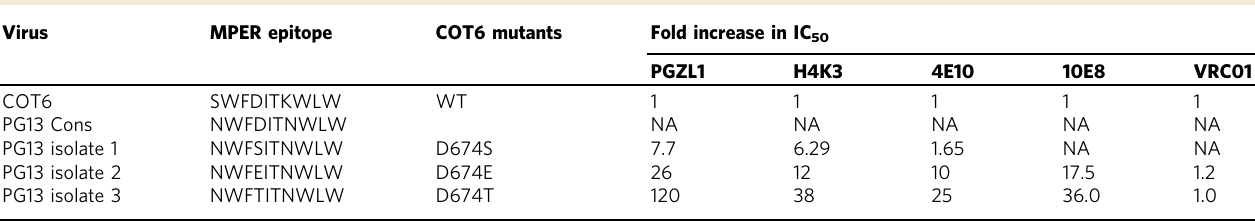
Table 1 Effect of MPER mutation on the neutralization of HIV COT6 by PGZL1 and control antibodies.